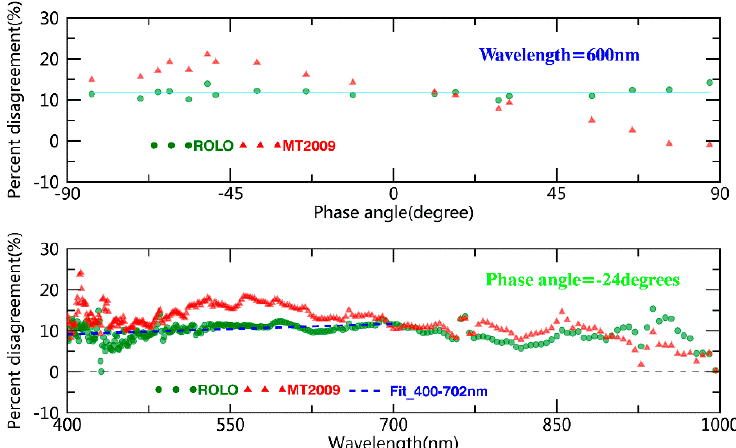
Figure 18. Comparisons of the measurements with the ROLO and MT2009 model. The upper panel shows the percent di ff erence with lunar phase at 600 nm, and the bottom panel shows the percent di ff erence with wavelength at phase angle = − 24 ◦ . For the ROLO model, the fitting line for the 400–700 nm is a blue-dashed line.